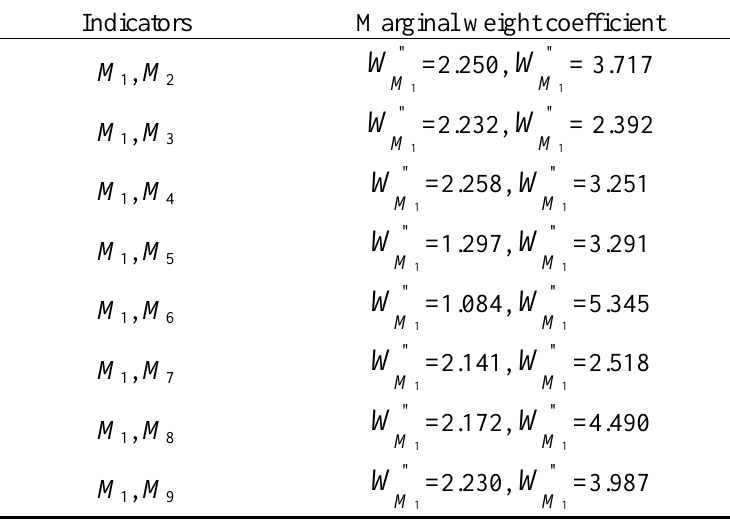
Table 7. Marginal weight coefficients of M